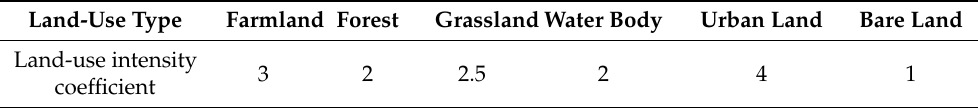
Table 2. The land-use intensity coefficient of different land use types